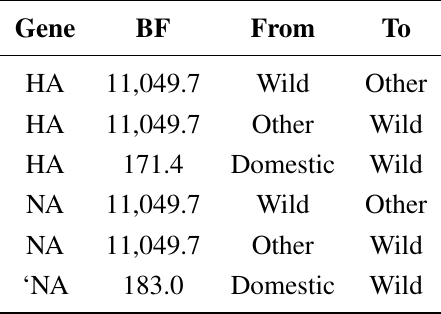
Table 1. Bayes factor (BF) tests for non-zero transition rates between host types for each gene region (HA, NA). BF values > 6 indicate significant rates of exchange between host